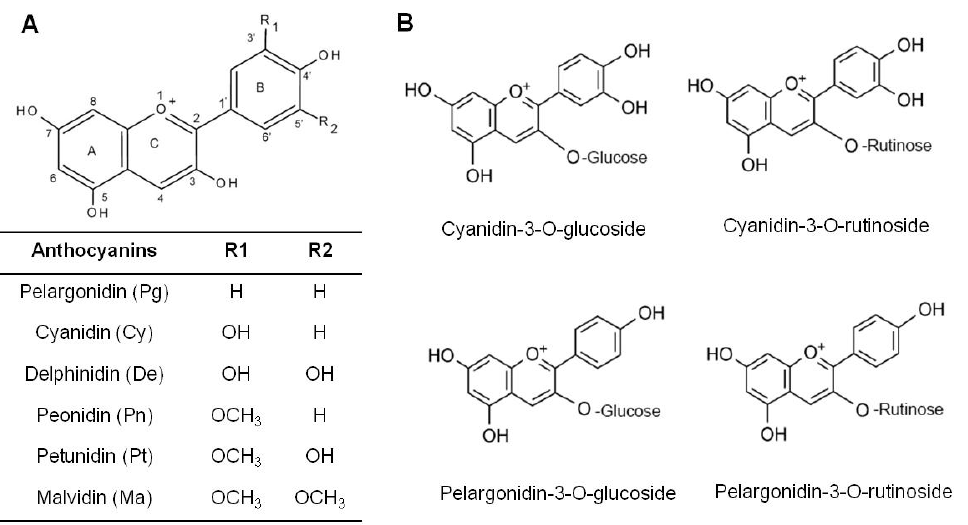
Figure 2. Structure of anthocyanins. ( A ) The structural classification of the six most common anthocyanins; ( B ) The structural classification of the four most common anthocyanins identified in strawberry and black raspberry. Table 2. Major components in strawberry and black raspberry.